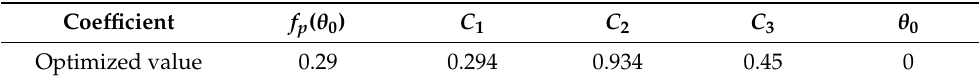
Figure 8. Trend and ratio chart of normal force and tangential force under different cutting angles. Table 4. Coefficients of proposed bone ploughing coefficient.